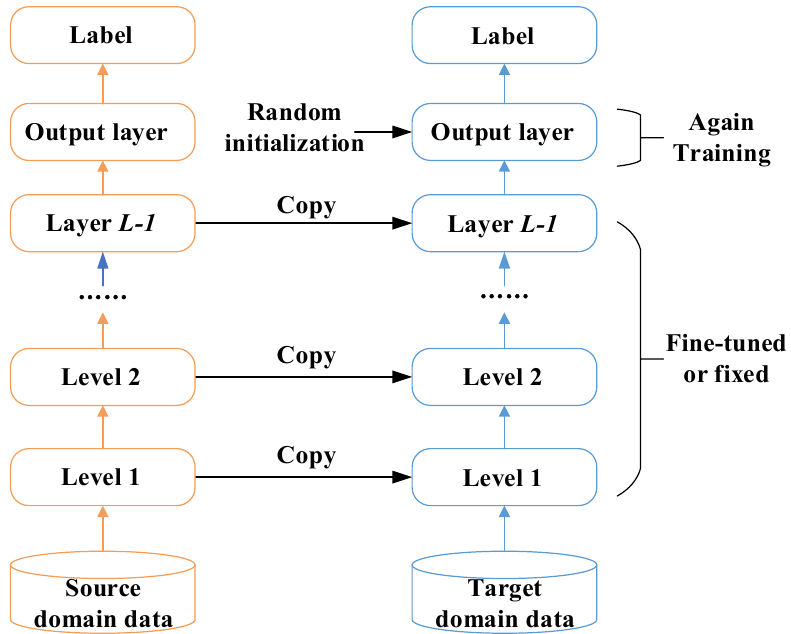
Figure 3. Schematic diagram of transfer learning method based on network model.